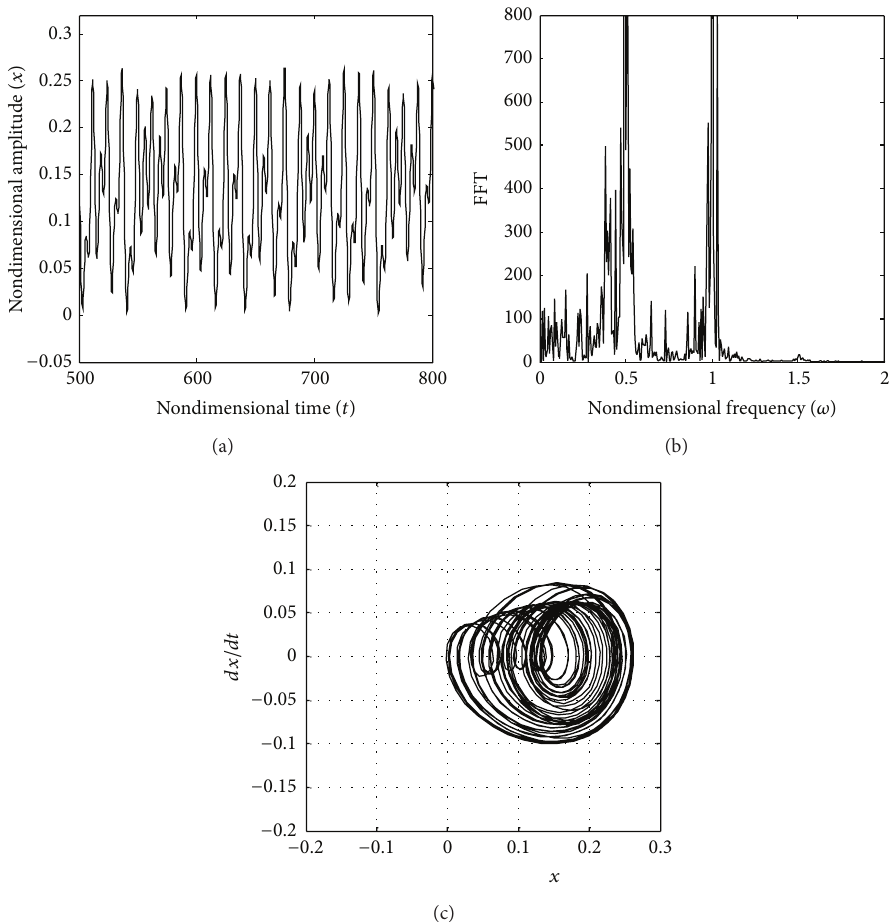
Figure 8: (a) Time history, (b) Fourier spectra, and (c) phase plane, for 𝑓 𝑝 = 0.45